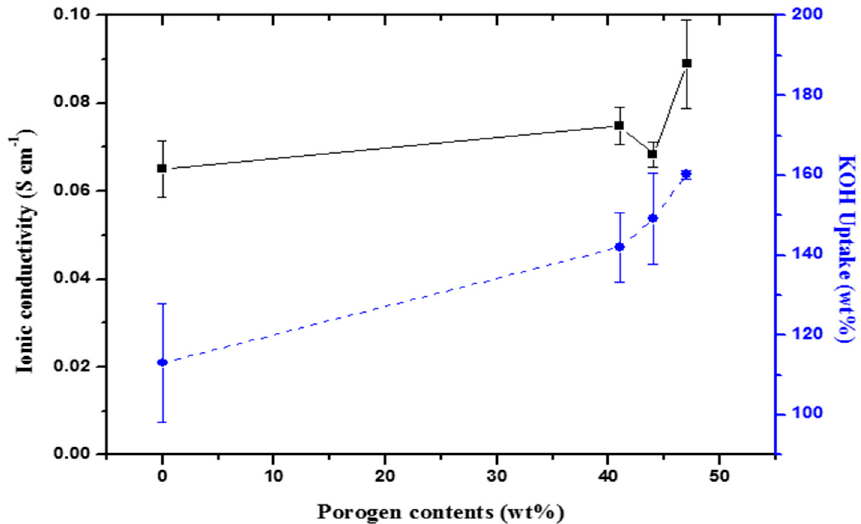
Figure 6. Ionic conductivity and KOH uptake of P-PBI membranes doped in 6 M KOH as a function of the content of porogen.